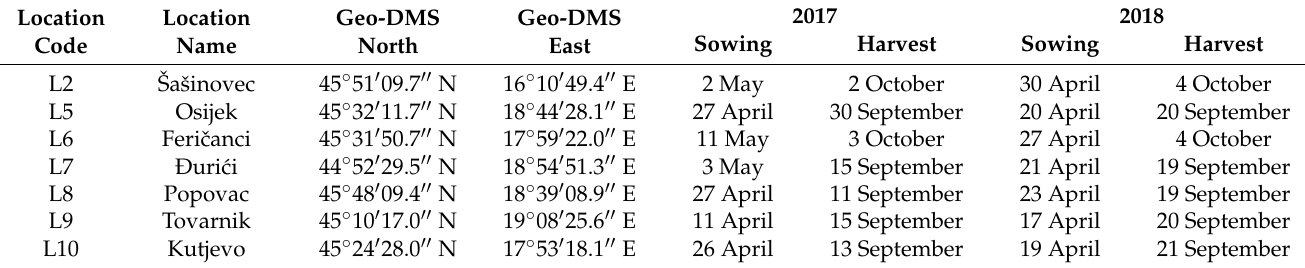
Table 2. List of locations for field experiments and sowing and harvest time for both